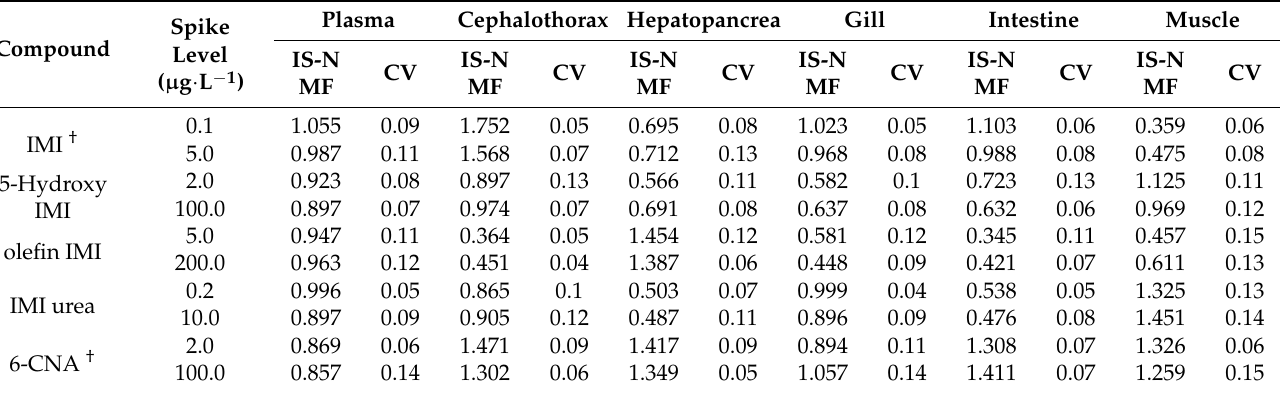
Table 2. Matrix effects of imidacloprid and metabolites in different